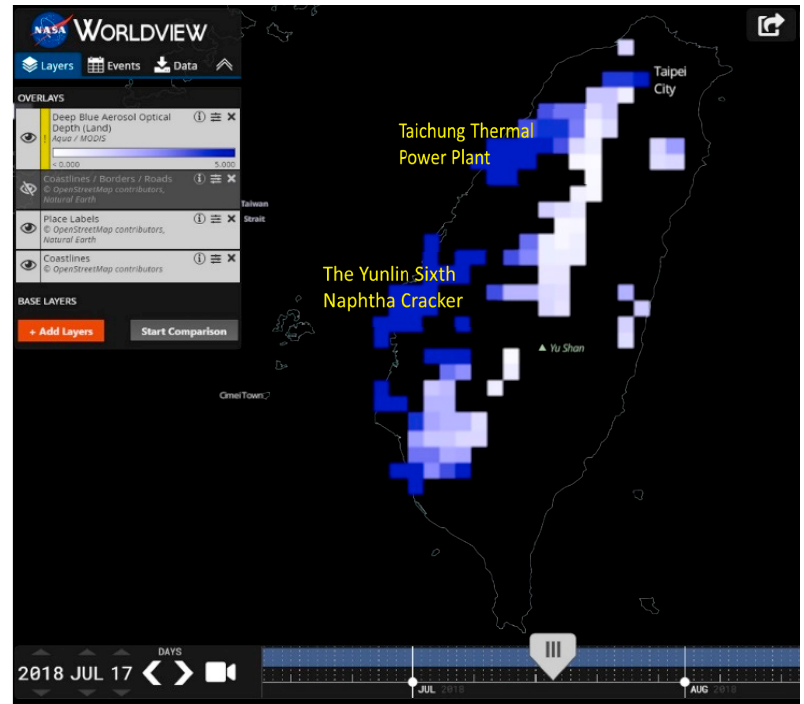
Figure 1. Aerosol optics depth (AOD) satellite image (17 July 2018) [3].